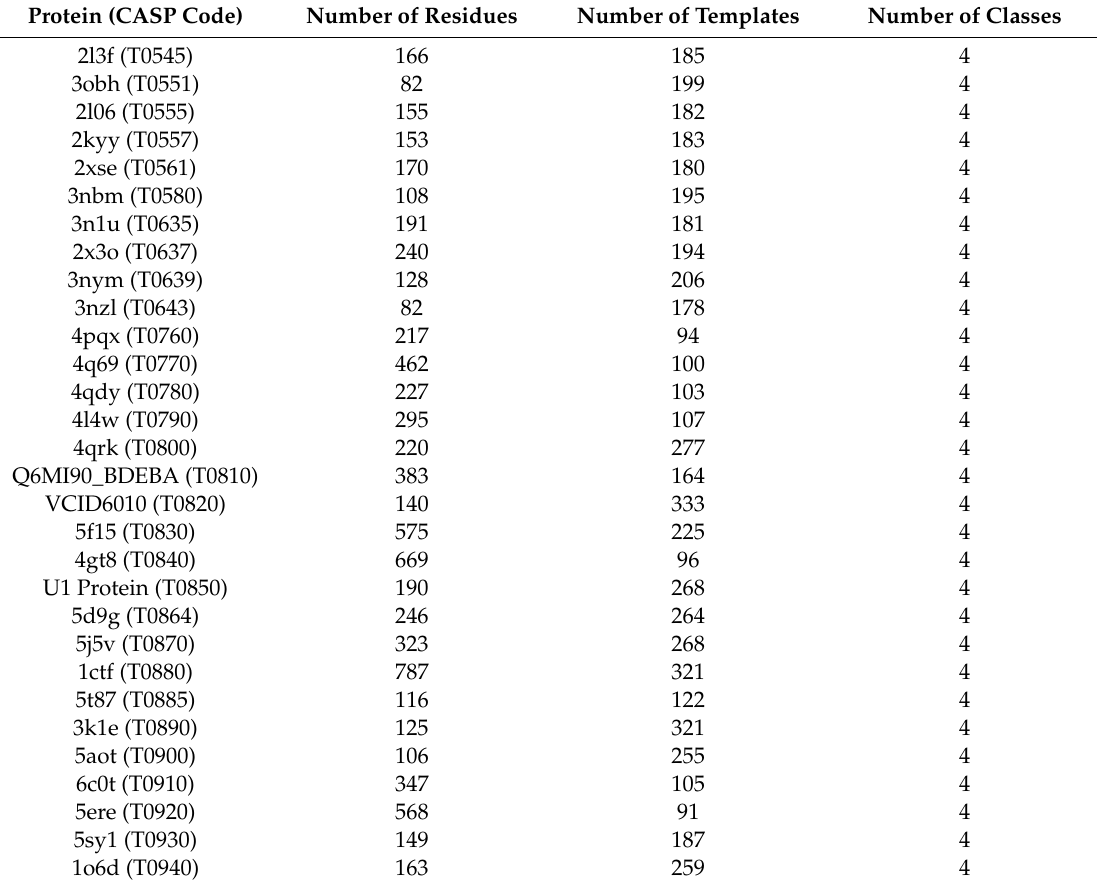
Table 1. Summary of the protein selected and the number of templates available alongside the class